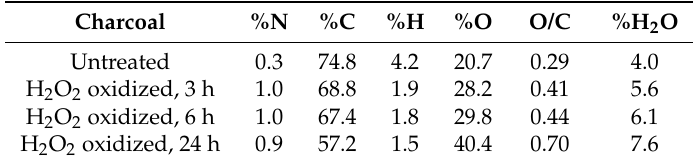
Table 1. Elemental analysis of charcoal after different times of oxidation by H 2 O 2 . The last column indicates the water content as determined by thermogravimetry.